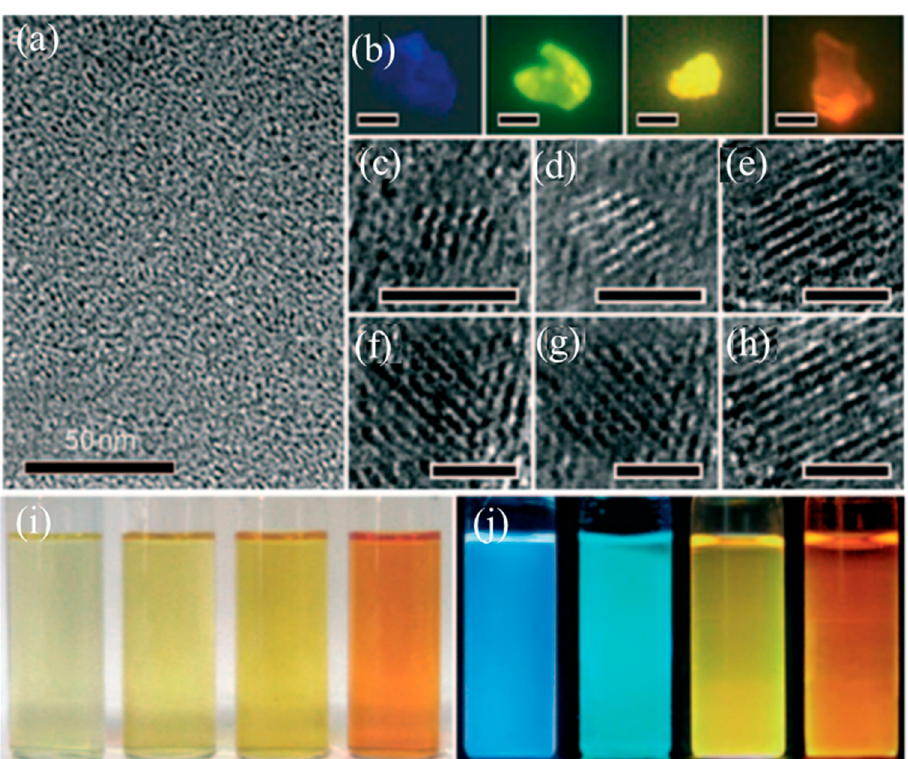
Figure 13. Quantum size effect in carbon quantum dots (CQDs). ( a ) TEM image of CQDs; ( b ) fluorescent microscopy images of CQDs with an excitation wavelength of 360 nm; ( c – h ) HRTEM images of typical CQDs with different diameters; typical sized CQDs optical images illuminated ( i ) underwhite (left; daylight lamp) and ( j ) UV light (right; 365 nm) [130]. Copyright 2010, John Wiley and Sons.